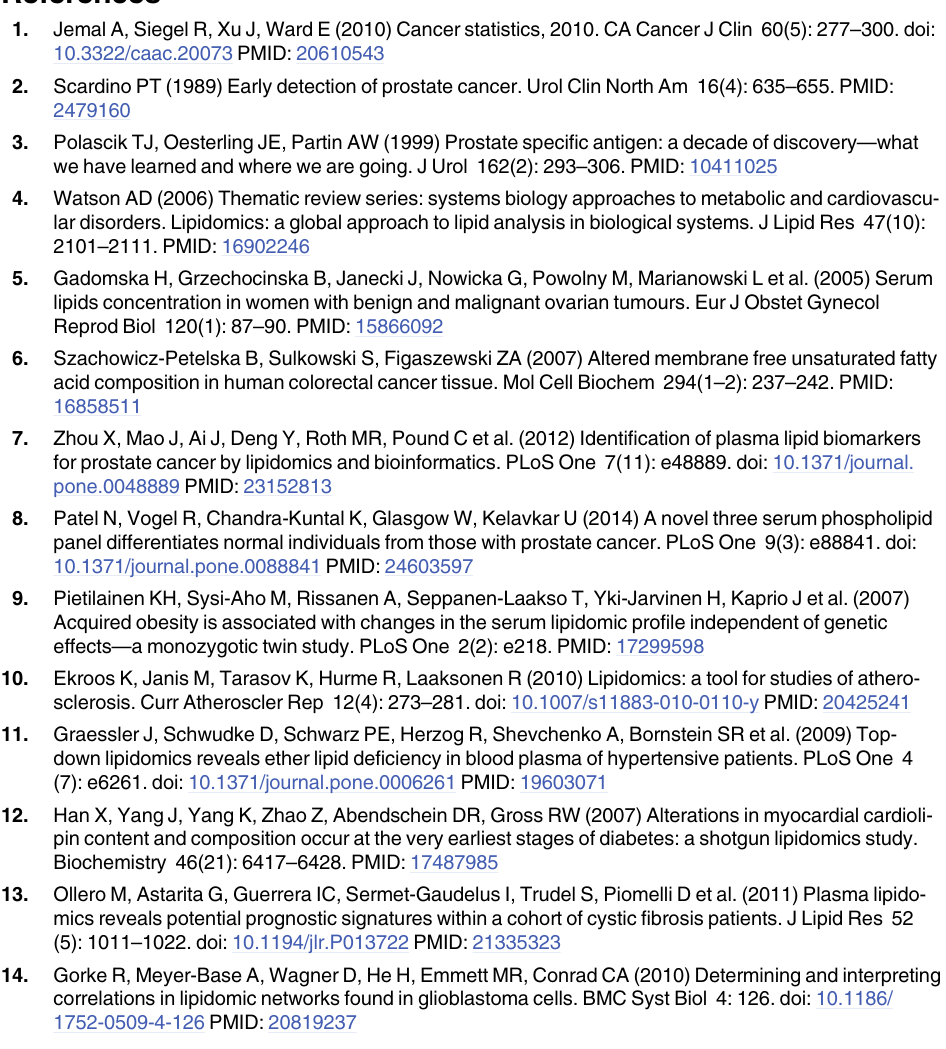
S3 Fig. Effect of ALA on proliferation of LNCaP and PC3 cells. The LNCaP and PC3 cells were treated with ALA of varying concentration (1 to 100 μ M) for 48 h and cell morphology was observed to determine effect of the ALA on proliferation of PCa cells.